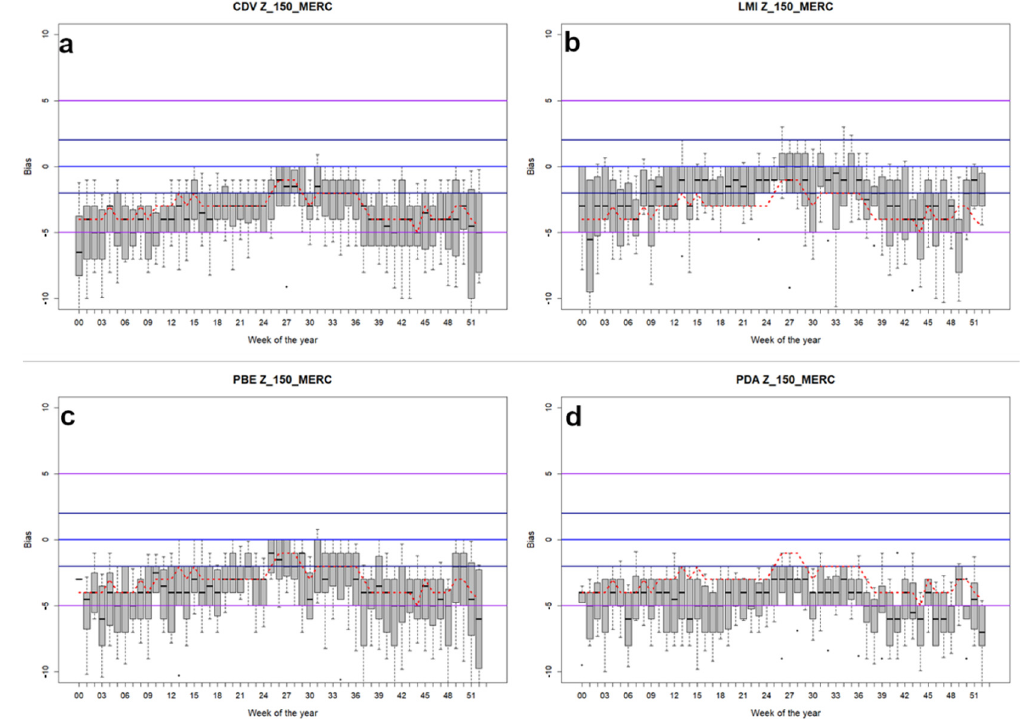
Figure 5. Boxplot showing weeks of the year and bias for the same radars as in Figure 3 (CDV—( a ), LMI—( b ), PBE—( c ),